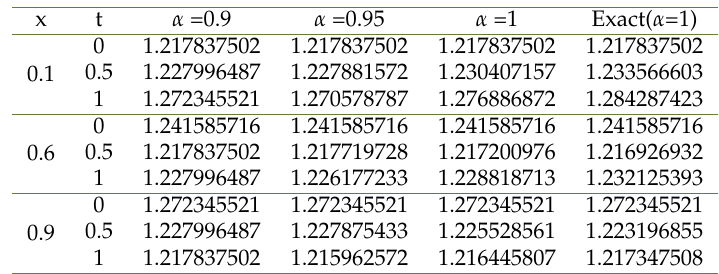
Table 2. Solution of Eq. (23) using DJM for different values of α